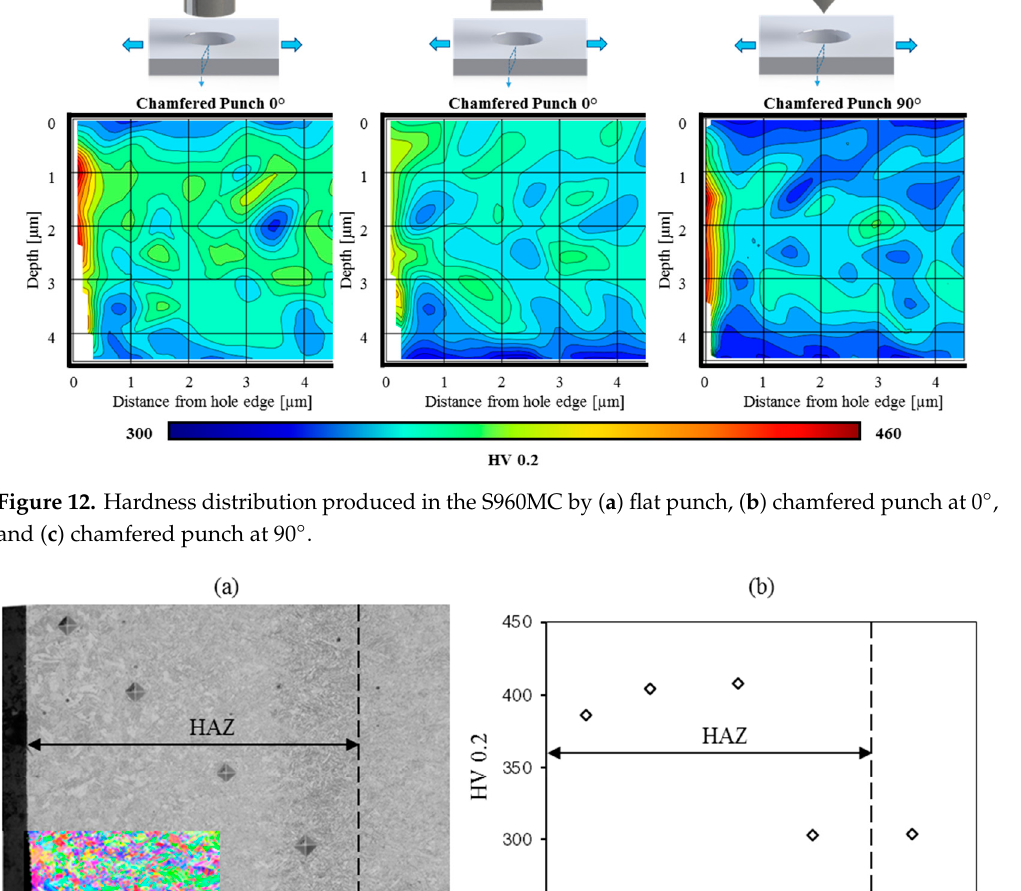
Figure 14. Hole edges of S500MC and S960MC measured with electron backscatter diffraction (EBSD). The EBSD inverse pole figure orientation map is given. The transition of different surface layers are marked with arrows in the S500MC grade: Ox, oxidation layer; fgz, fine-grained zone; HAZ, heat- affected zone. In Figure 15 an overview of the hole edges is shown. The EBSD maps are measured with a step size of 0.50 μ m for the laser-cut samples and 0.25 μ m for the punched S960MC sample. For the S500MC grade, the transition to the ferritic microstructure is visible. To image highly deformed materials the spatial resolution needs to be smaller than the size of the dislocation cells [30]. The acquired EBSD patterns became weaker with high deformation, resulting in low confidence index values at the hole edge of the punched samples, but the transition from the base material to the deformed material is visible.